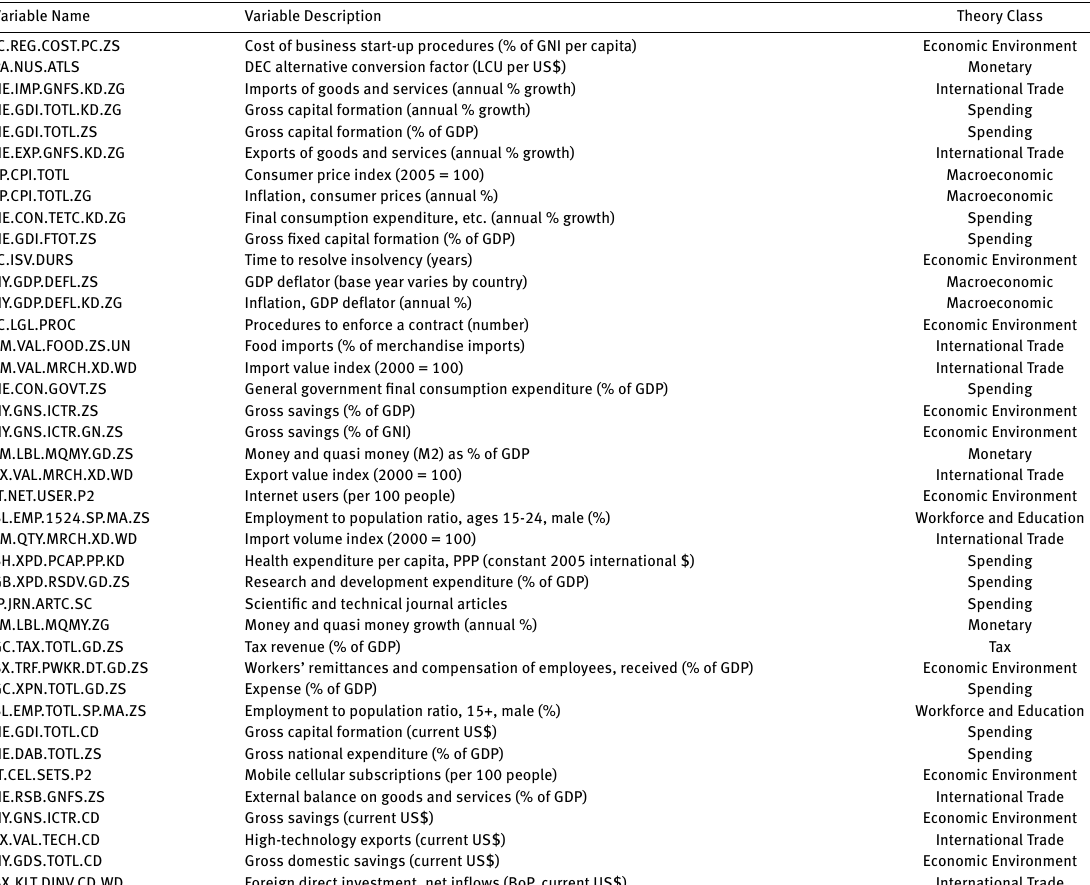
Table 9: List of Applied Risk Indicators